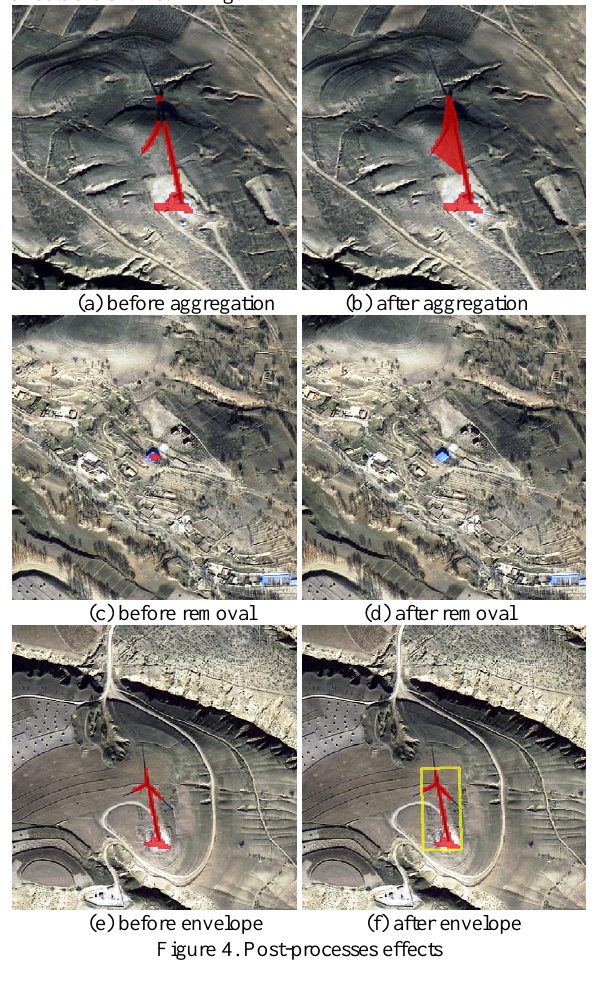
Figure 4. Post-processes